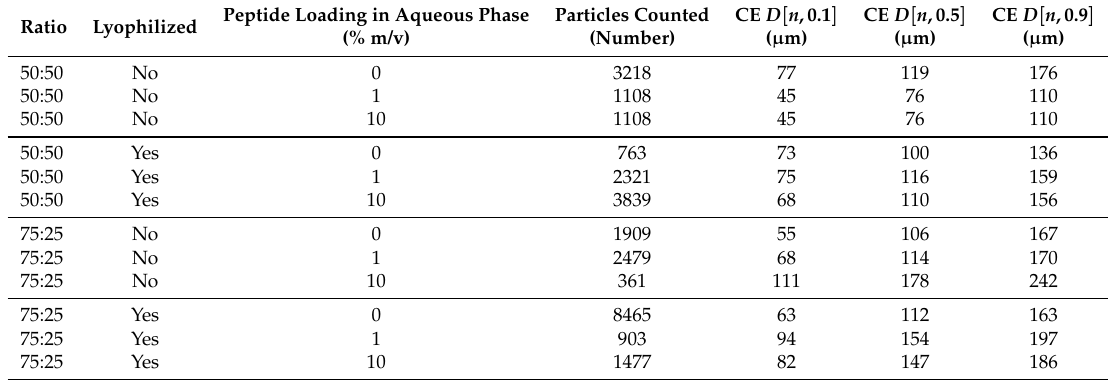
Table 2. Morphology data for unlyophilized samples and lyophilized samples. CE is the circular equivalent diameter: the diameter of a circle with the same area as the 2D projection image of the